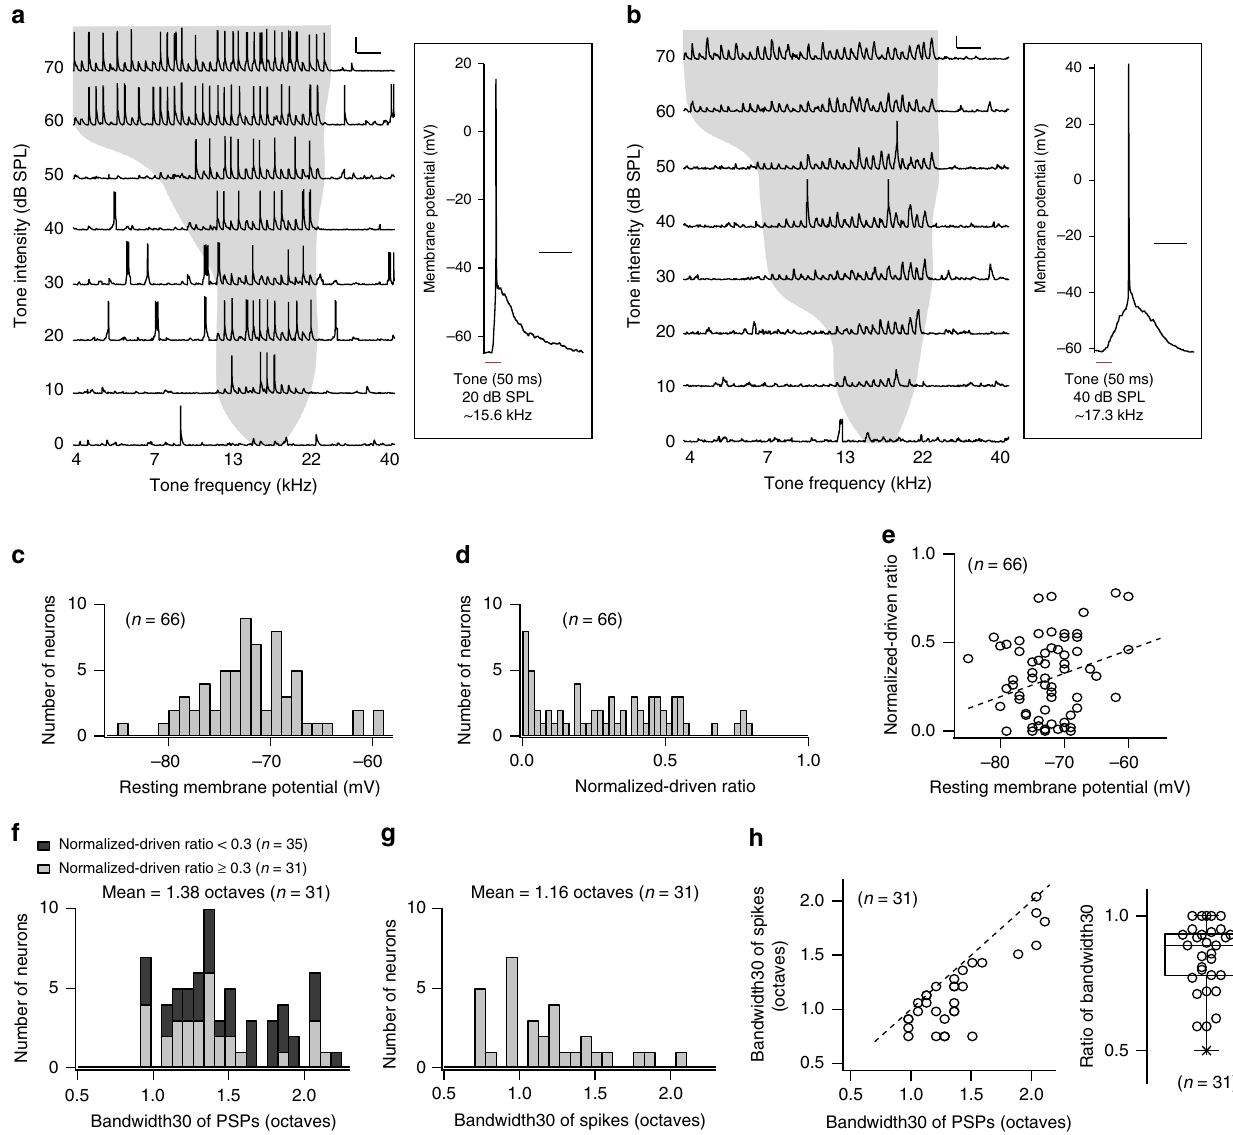
Fig. 1 Tonal receptive fi elds obtained from in vivo current-clamp whole-cell recordings to pure tones. a A representative example with a high normalized-driven ratio of 0.57. This example had a characteristic frequency of ~17 kHz and a bandwidth30 of ~1 octave within a TRF region (the shaded area). Horizontal scale: 1 s; vertical scale: 30 mV. The inset on the right shows an enlarged view of one representative trace obtained from a tone among a set of 360 combinations. Scale bar, 0.1 s. b A representative example with a low normalized-driven ratio of 0.02. The neuron had a characteristic frequency of ~17 kHz and a bandwidth30 of ~1.7 octaves within a TRF region. Spikes have been truncated to illustrate relatively small subthreshold membrane potential responses well. Horizontal scale: 1 s; vertical scale: 10 mV. The inset on the right shows an enlarged view of one representative trace obtained from a tone among a set of 360 combinations. Scale bar, 0.1 s. c Histogram of resting membrane potentials ( n = 66 neurons from 41 mice). d Histogram of normalized-driven ratios ( n = 66). e Relationship between normalized-driven ratios and resting membrane potentials. f Histograms of the bandwidth30s of PSPs (normalized-driven ratio < 0.3, n = 35, dark gray; normalized-driven ratio ≥ 0.3, n = 31, light gray). g Histogram of the bandwidth30s of spikes ( n = 31/66 with normalized-driven ratio ≥ 0.3). h Relationship between the bandwidth30s of PSPs and the bandwidth30s of spikes ( n = 31/66 with normalized- driven ratio ≥ 0.3). The two groups were statistically signi fi cantly different (two-tailed paired Student ’ s t -test; p = 10 − 6 ). On the right, the box plot indicates ratios of the spike bandwidth30 to the PSP bandwidth30. The lower and upper hinges are at the 25th and 75th percentiles. The median by the middle line between hinges was 0.89. Asterisks indicate outliers. The minimum value is marked by the lower whisker. distributions for non-spiking events were either bimodal (Fig. 2a, b, likely represent the integration of multiple synchronous synaptic top right; magenta and green) or unimodal in 60% ( n = 24/40) inputs from many synapses, since unitary synaptic inputs usually and 40% ( n = 16/40) of the recorded neurons, respectively. For have an amplitude of ~1 mV 22,23 . STRFs were estimated for the three different response events by bimodal PSP histograms, PSP amplitudes were subdivided into extracting peak timing information for spikes (black tick marks large (magenta) and small (green) events at the trough between below the voltage traces), and non-spike related large (magenta), the two maxima. When a PSP histogram was unimodal, large and and small (green) PSPs (Fig. 2a, b, bottom). Very small events small PSP amplitudes were divided at approximately 50% of the (marked gray in amplitude histogram) indicate events less than number of non-spiking PSPs. Both large and small PSPs (Fig. 2) NATURE COMMUNICATIONS| (2020) 11:1102